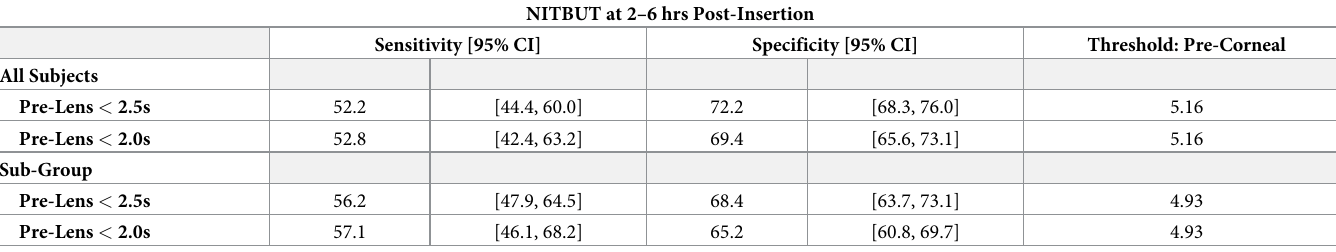
Table 3. Sensitivity and specificity of pre-corneal NITBUT for predicting subsequent pre-lens NITBUT at 2–6 hrs post-insertion below thresholds associated with any dryness symptoms (2.5 sec) and severe dryness symptoms (2.0